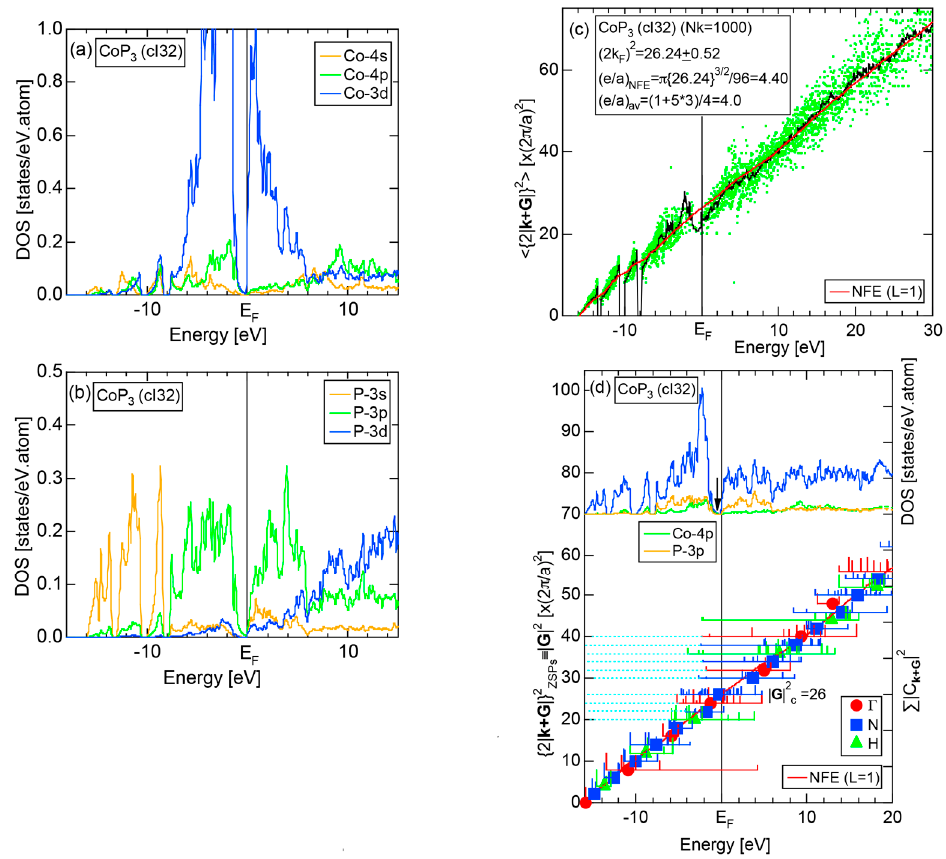
Figure 80. ( a ) Co- and ( b ) P-pDOSs, ( c ) Hume-Rothery plot and ( d ) FLAPW-Fourier spectra at symmetry points Γ , N, and H of the bcc Brillouin zone along with the total DOS (blue), Co-4p (green) and P-3p (yellow) for CoP 3 (cI32) [11,12]. See captions of Figure 19 (b) for symbols in (c) [1,3].